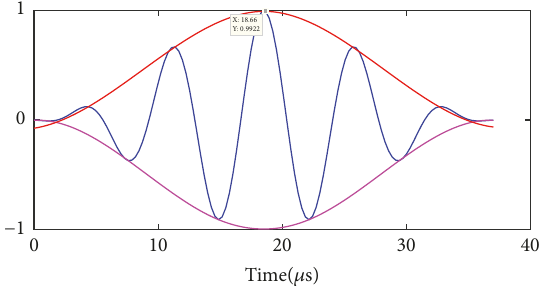
Figure 9: Excitation signal of FEM